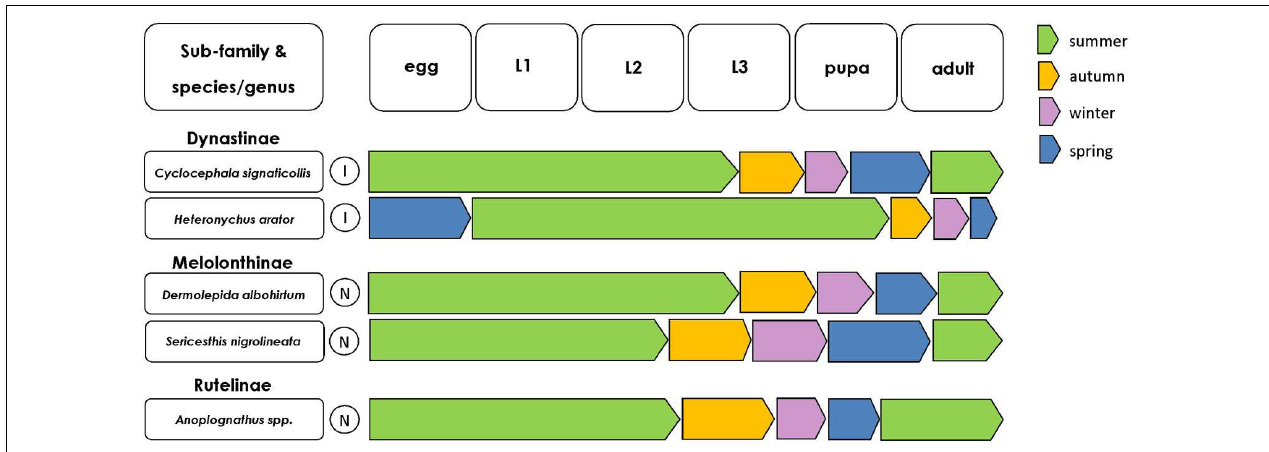
FIGURE 3 | Seasonal occurrence of scarab life stages for each of the key scarab pest species. Such information can help to design life-stage specific, targeted pest control programs. Color of arrows indicates the season in which each scarab life stage typically occurs (within Australia and New Zealand). Circles with I indicate species invasive to Australasia, circles with N indicate species native to Australasia.